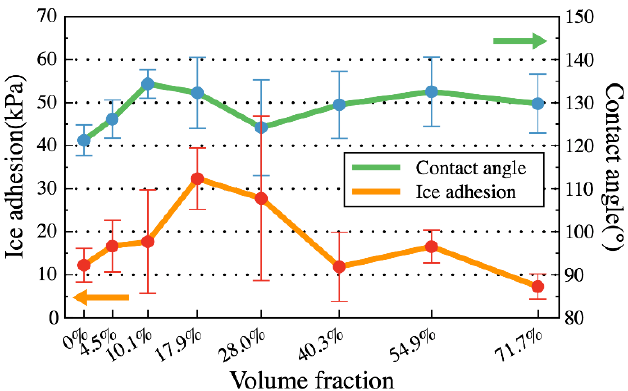
Figure 8. The ice adhesion and the contact angle of the hydrophobic nano-pillar array-fluoridated epoxy (1 wt %) plot at a volume fraction of nano-pillar structure on the epoxy